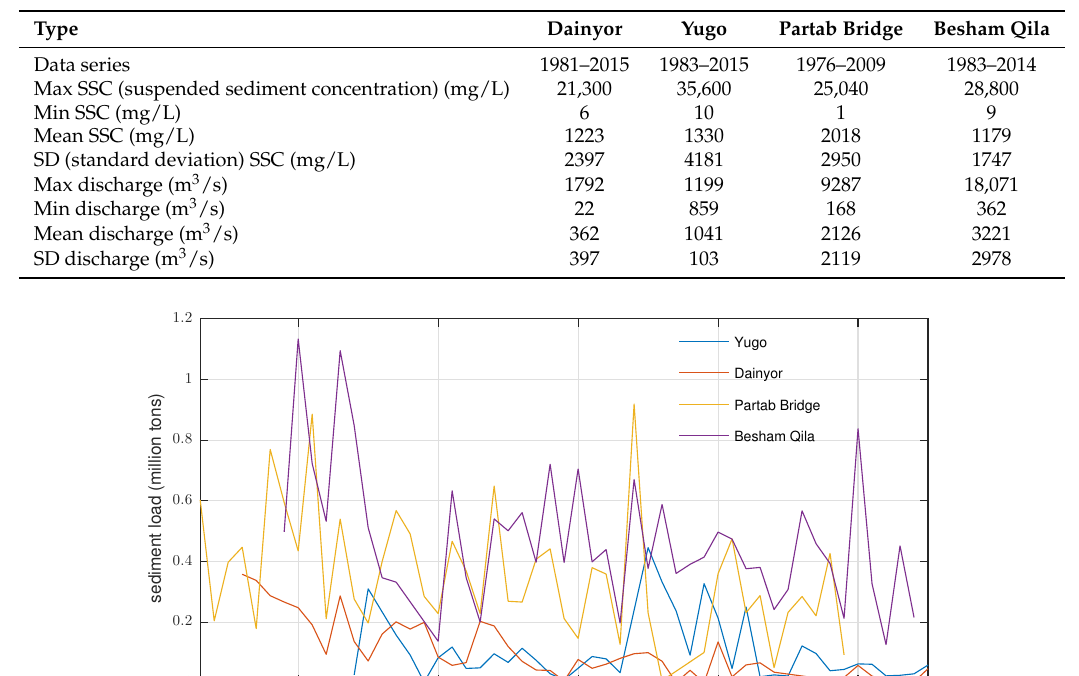
Table 1. Data characteristics.